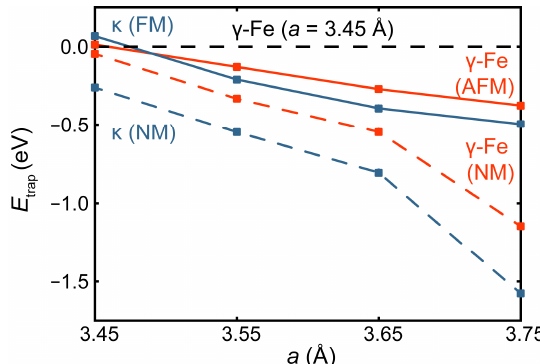
Figure 4. Trapping energy E trap of a single H atom as a function of the number of Mn atoms in its first CS for a 3 × 3 × 3 L 1 2 -Fe 1.5 Mn 1.5 Al supercell with C sublattice concentrations of 0% (red), 50% (blue), Figure 5. Trapping energy E trap of a single H atom as a function of cell volume (via the lattice and 96% (green). parameter a ) for fcc-Fe (red) and the L 1 2 -Fe 3 Al matrix (blue) considering different magnetic states, with the dashed/solid lines signifying the nonmagnetic/magnetic cases.